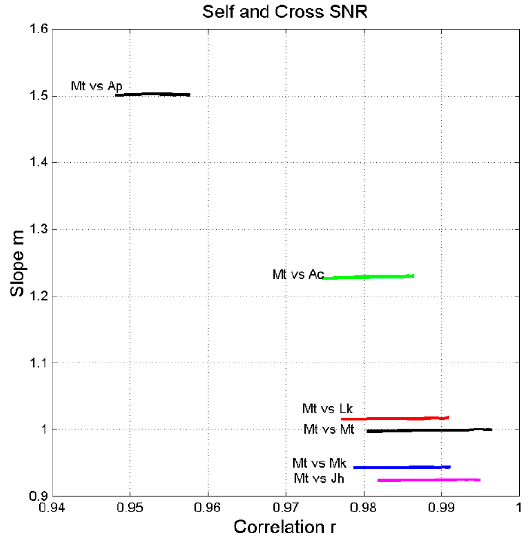
Figure 14. Scatter plot between correlation coefficient 𝑟 and line slope 𝑚 for Matthew self ‐ channel (Mt vs. Mt) and Matthew cross ‐ channels Mt vs. Mk (blue), Mt vs. Lk (red), Mt vs. Jh (magenta), Mt vs. Ac (green), Mt vs. Ap (black).